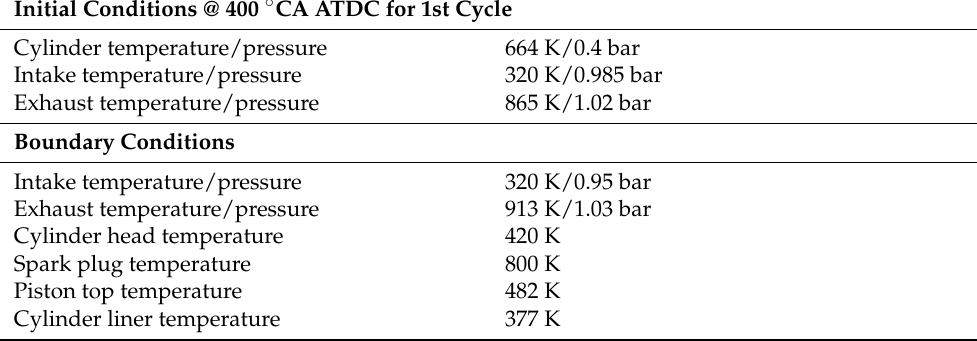
Table 3. Simulation